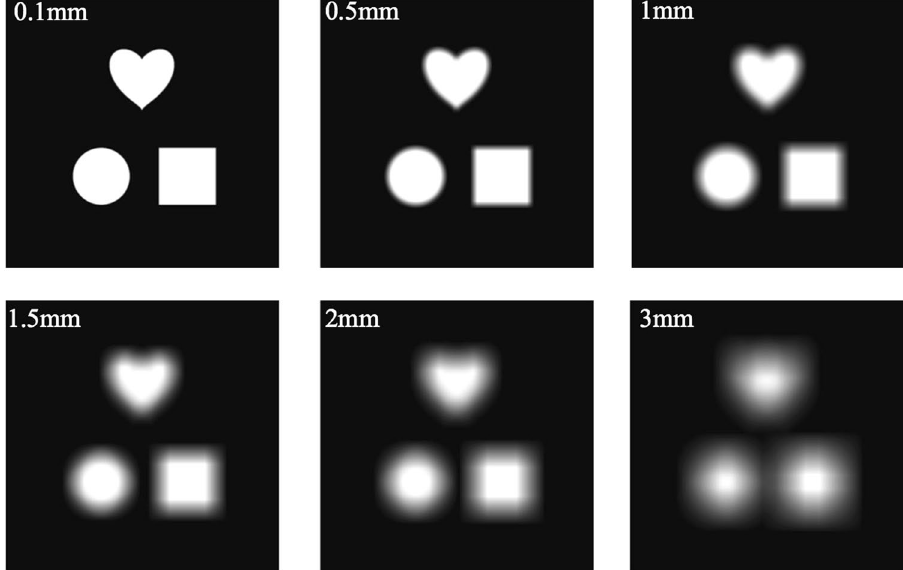
Figure 3. Simulation results of a target image convolved with square light sources of different sizes of 0.1 mm, 0.5 mm, 1 mm, 1.5 mm, 2 mm and 3 mm, respectively. The wavelength in use is 532